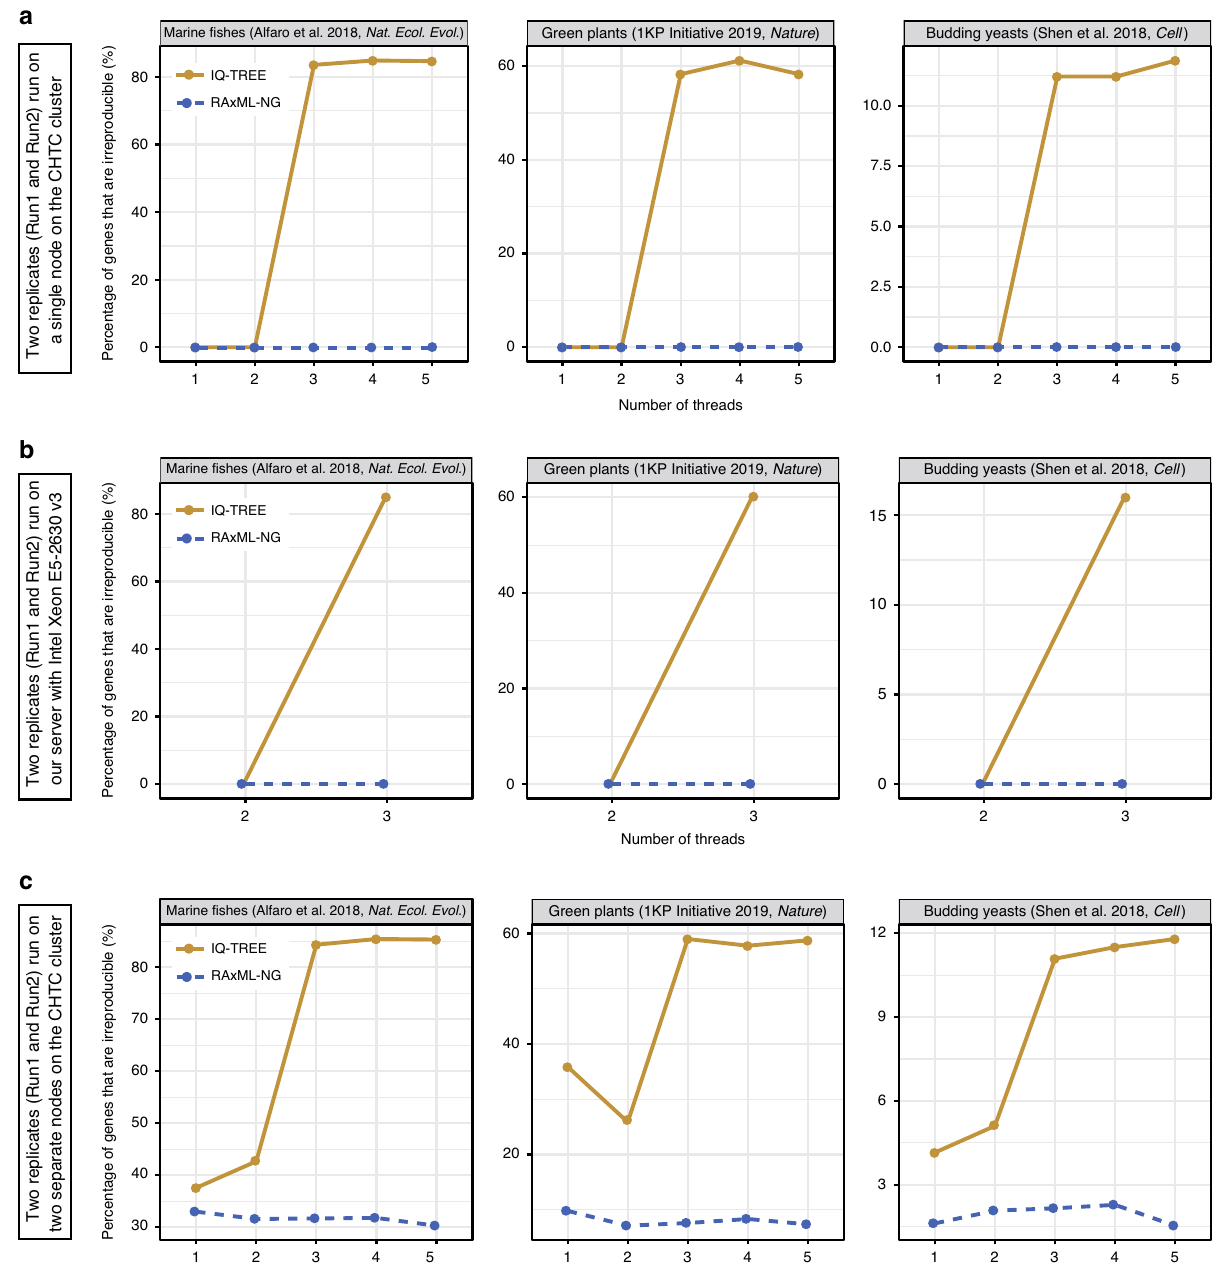
Fig. 5 Variation in computing resources affects the irreproducibility of single-gene trees. Three large representative studies in animals (marine fi shes: 1001 genes and 120 taxa from Alfaro et al. 65 ), plants (green plants: 410 genes and 1178 taxa from 1KP Initiative 66 ), and fungi (budding yeasts: 2408 genes and 343 taxa from Shen et al. 16 ) were used to examine the impact of threading and processor types on the reproducibility of gene phylogenies. Percentages of the 3819 genes whose phylogenies are irreproducible when a we ran two replicates (Run1 and Run2) on a single node (the two replicates were run one right after the other on the same node) on an increasing number of threads on the CHTC cluster using IQ-TREE (in yellow) and RAxML-NG (in blue), respectively. Since running all 3819 genes on a single laboratory server was computationally intractable, we sampled the fi rst 200 genes from each data set. Percentages of these 600 genes when b we ran two replicates on a laboratory server (Intel Xeon E5 – 2630 v3 @ 2.40GHz processor with 16 threads) on an increasing number of threads using IQ-TREE (in yellow) and RAxML-NG (in blue), respectively. Percentages of the 3819 genes whose phylogenies are irreproducible when c we ran two replicates (Run1 and Run2) on two separate nodes (i.e., each analysis was run on a single node, but Run1 was executed on a different node than Run2) on an increasing number of threads on the CHTC cluster using IQ-TREE (in yellow) and RAxML-NG (in blue), respectively. The irreproducibility of each gene was determined by comparing the topologies of single-gene trees generated by two replicates (Run1 and Run2). These results suggest that multithreading, coupled with the use of different nodes, is a major contributing factor to irreproducibility in IQ-TREE and that the use of different nodes, but not multithreading, is a major contributing factor to irreproducibility in RAxML-NG. Command lines and job submission fi les are given in Supplementary Note 1. All gene trees, log fi les, and statistics of the results, are available on the fi gshare repository: https://doi.org/ 10.6084/m9. fi